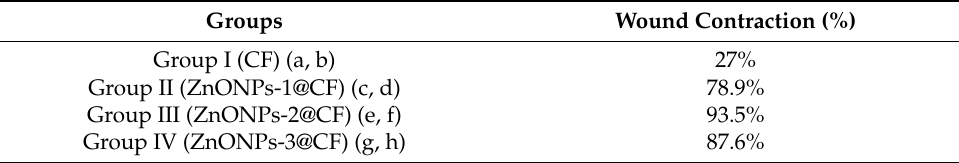
Table 2. Wound healing percent of diabetic rats treated with